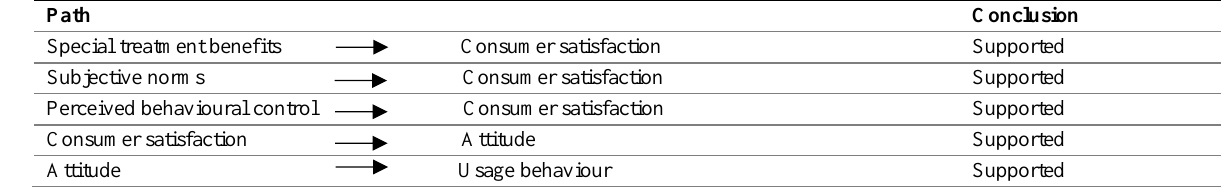
Table 6: Summary of the findings concerning the hypothesis